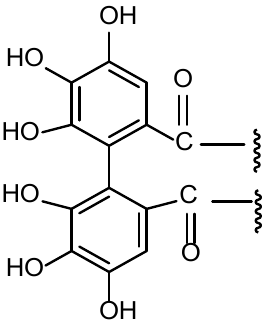
Figure 1 Structure of Hexahydroxidiphenic Group of